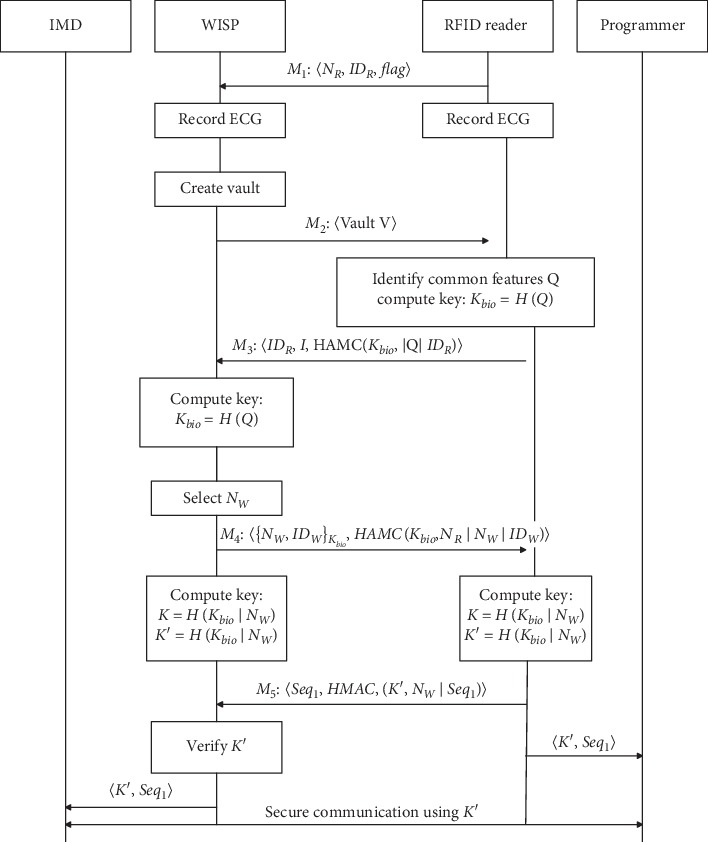
Mutual authentication protocol in the emergency mode (protocol 1).